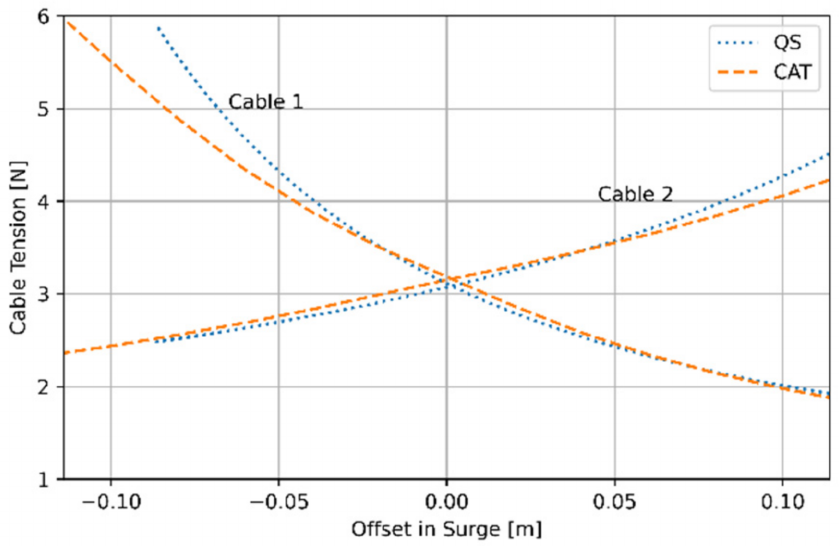
Figure 16. Cable tensions versus static buoy offset for the QS analysis and the CAT